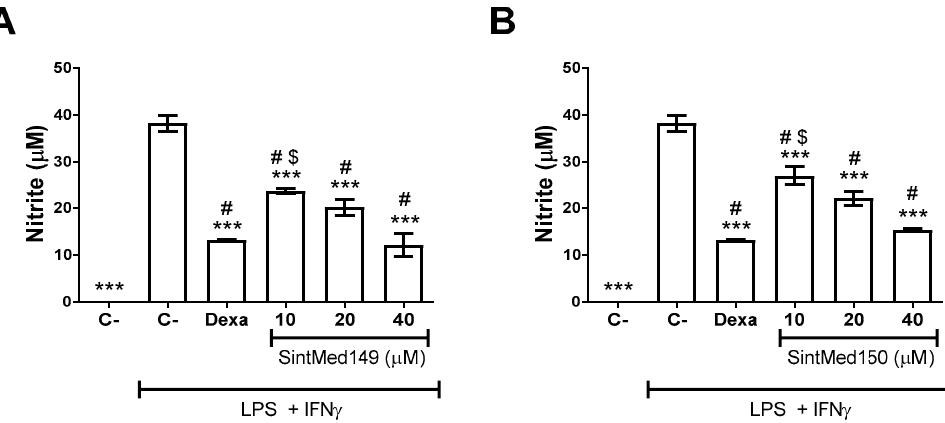
Figure 4. Ferrocenyl- N -acyl hydrazones SintMed149 and SintMed150 inhibit nitrite production by activated macrophages. Nitrite concentrations were determined in macrophage culture supernatants treated or not with hydrazones SintMed149 ( A ) and SintMed150 ( B ) (10, 20, and 40 µ M) or dexamethasone (Dexa; 10 µ M) in the presence of LPS (500 ng/mL) and IFN- γ (5 ng/mL). Values represent the mean ( ± standard deviation) of four determinations obtained in one of three experiments performed. *** p < 0.001 compared to untreated and LPS + IFN- γ -stimulated cultures. # p < 0.05 compared to untreated and unstimulated cultures with LPS + IFN- γ . $ p < 0.05 compared to dexamethasone-treated and stimulated cultures.